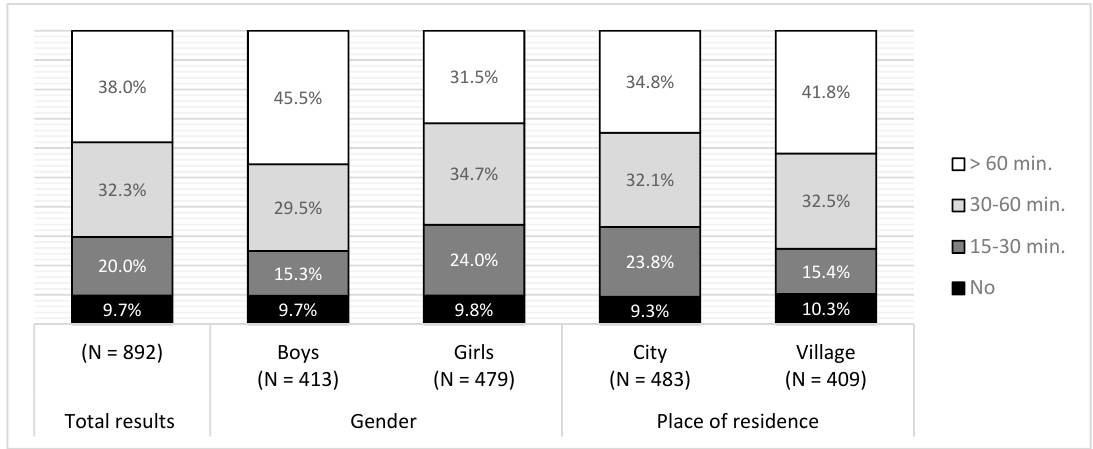
Figure 1. Physical activity in the total surveyed population and sub-groups according to gender and place of residence.